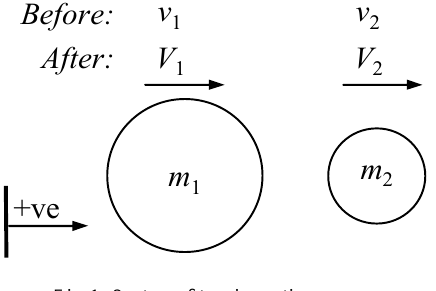
Fig. 1. System of two impacting